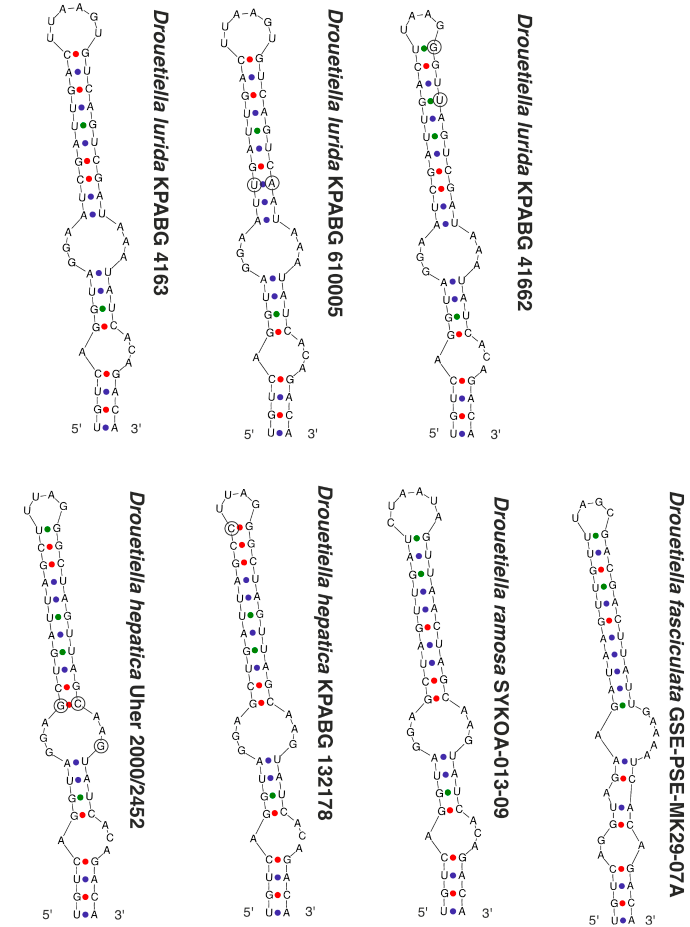
Figure 9. The secondary structure of the V3 helices of the 16S-23S ITS region in Drouetiella strains. Circles indicate differences.